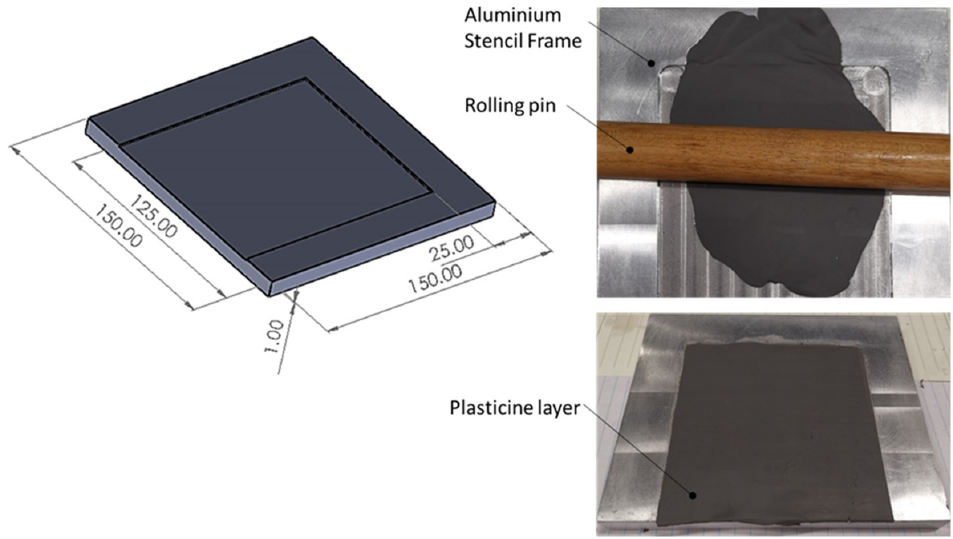
Figure 5. Tools to make plasticine layers of 1 mm.